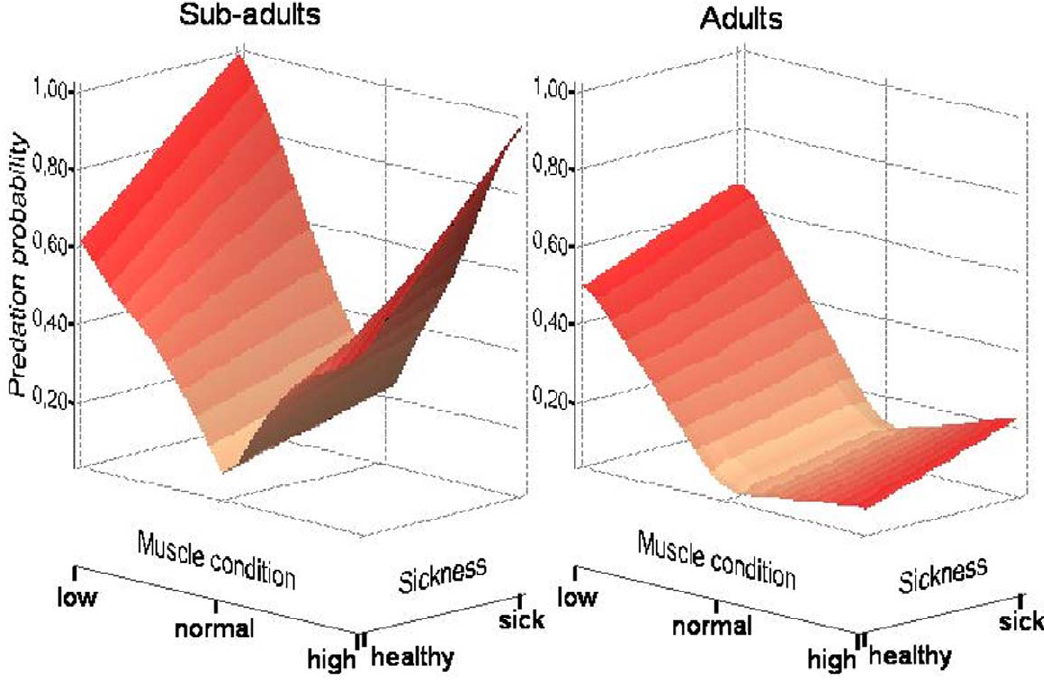
Figure 2. Determinants of probability of being predated by the raptors. All juveniles and immature classes were grouped in a single, sub- adult age class and compared with adult gulls. Smoothing regression surfaces are represented using a Lowess method by iteration of weighted least squares on the selected variables. Highest probability of being killed by predators occurred on sub-adult gulls with severe sicknesses and abnormal muscle condition.